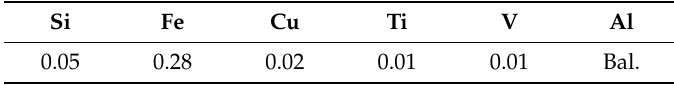
Table 1. Chemical composition of the blank aluminum disks (mass